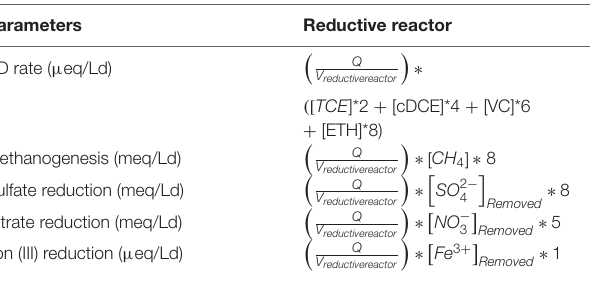
TABLE 1 | Calculations for estimation of rates of the main processes occurring in the reductive reactor.